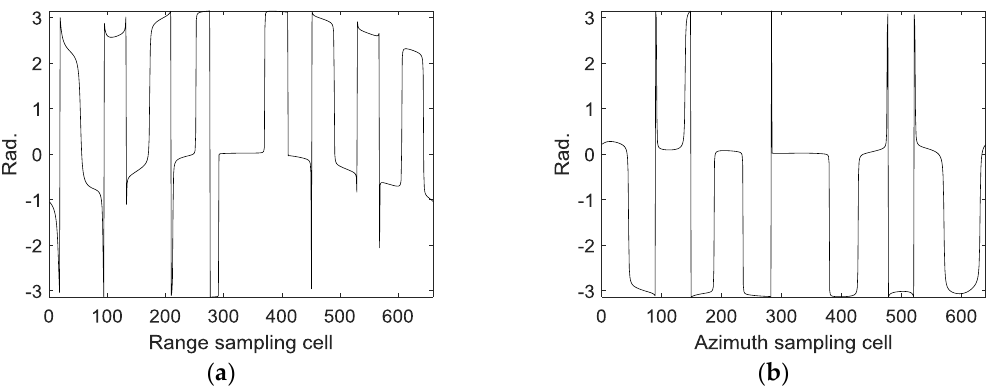
Figure 10. Phase of the point target processed by the proposed algorithm: ( a ) phase in range; ( b ) phase in azimuth.